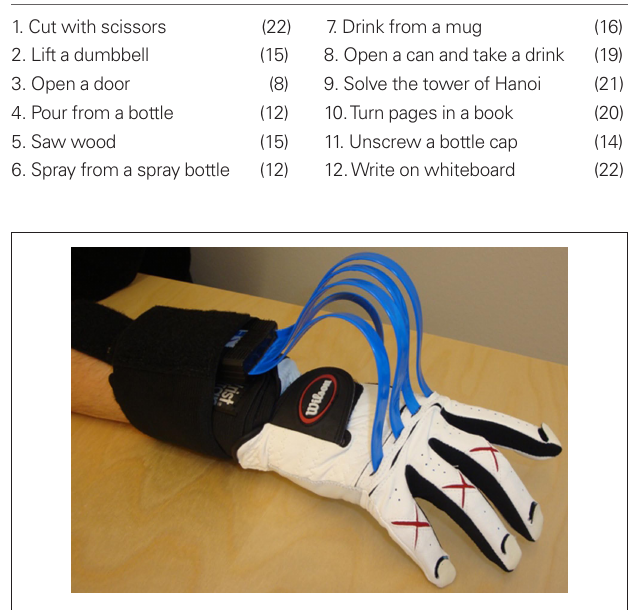
Figure 1 | ShapeHand™ motion capture